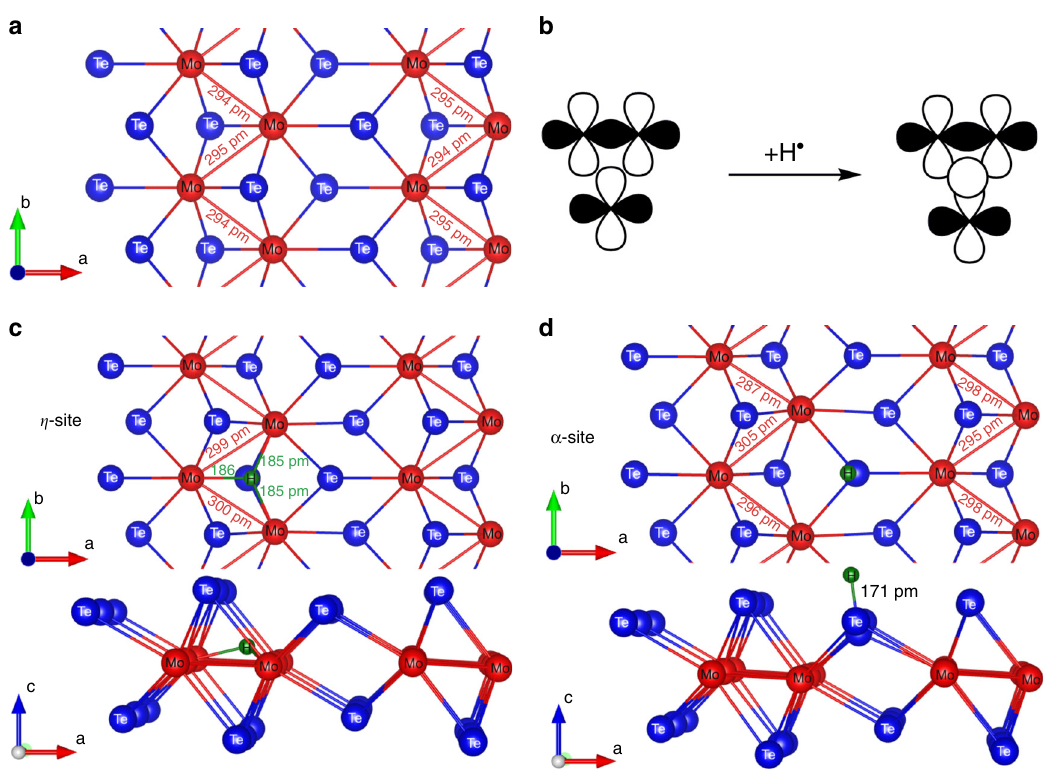
Fig. 4 Computational studies of hydrogen adsorption on the surface of 1T ′ -MoTe 2 . a The ab-plane projection of the optimised 2 × 2 unit cell of 1T ′ -MoTe 2 monolayer slab with selected calculated bond distances in pm (rev-PBE-D3/DZP + NO). b Schematic of frontier orbital symmetry with an H-adatom in the midpoint of the trinuclear bond axis. Optimised structures and bond distances (pm) of the regio-isomers of 2 1 ½ MoTe 2 H adsorbed at ( c ) η -site and ( d ) α